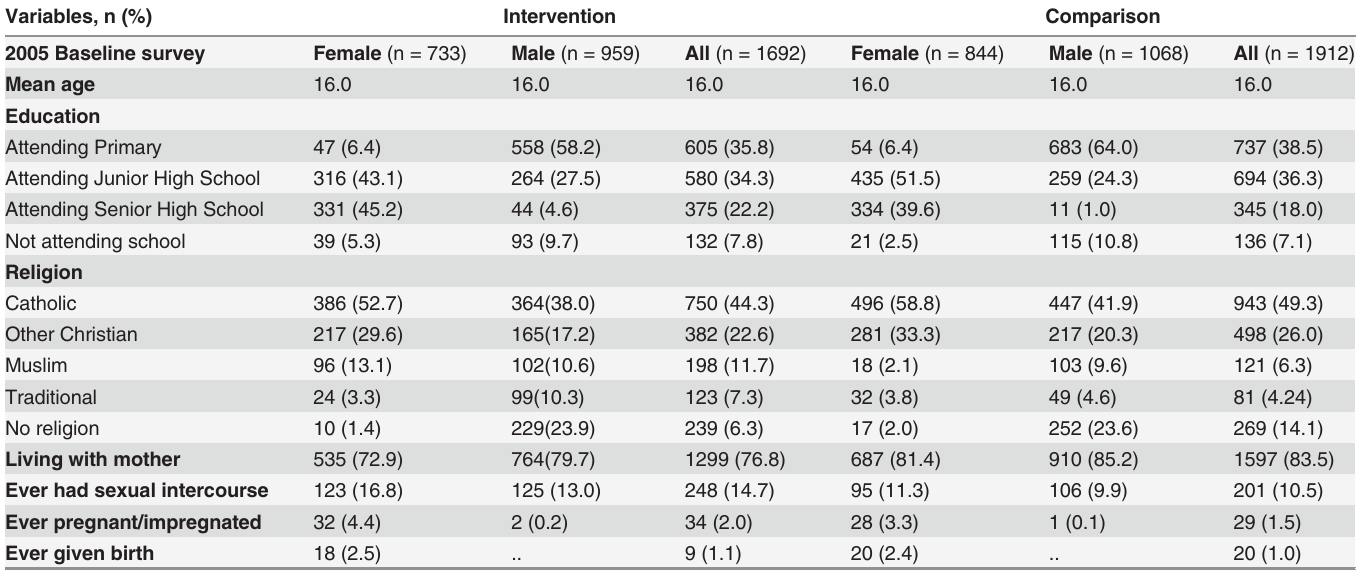
Table 1. Demographic characteristics at baseline, comparing intervention to comparison adolescents disaggregated by gender. Variables, n (%)